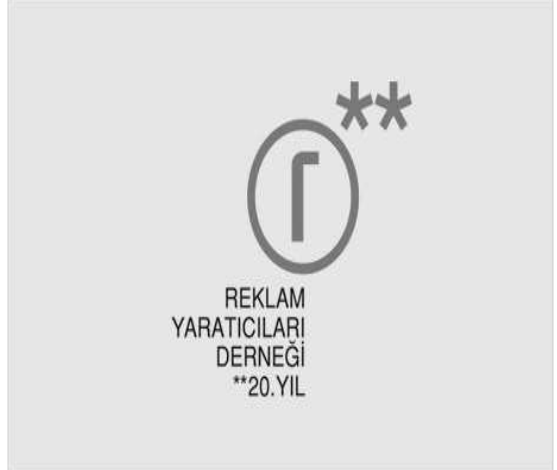
Fig. 14. Mete Özkar: Advertisement Creator’s Association’s (RYD) 20th Anni- versary Emblem and Logotype.